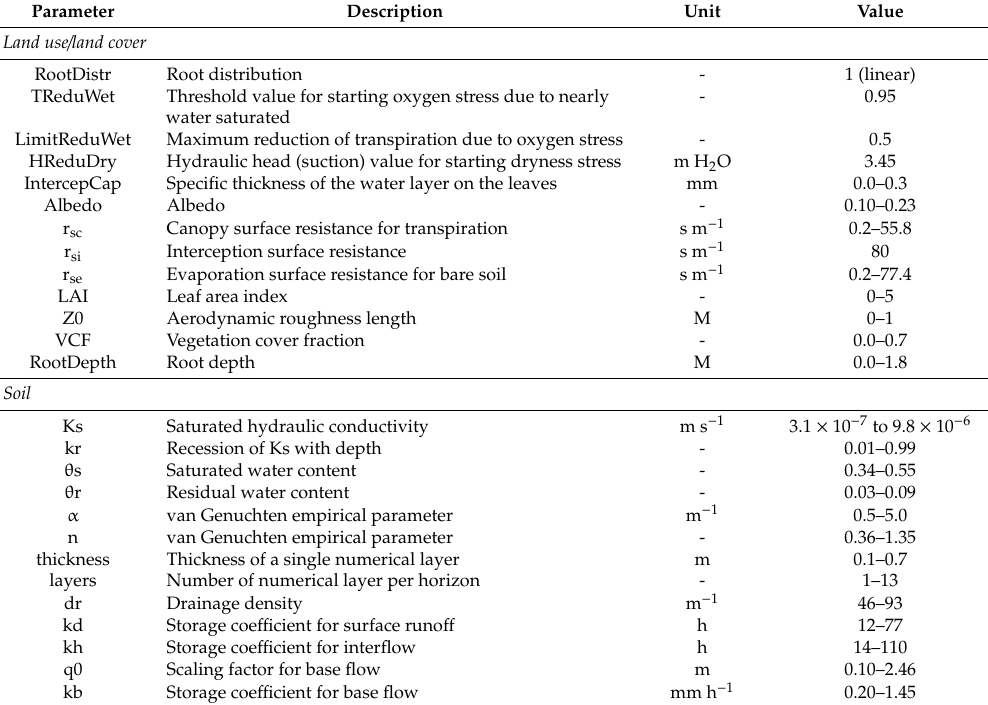
Table 8. Summary of the final WaSiM parameters for the Bankandi-Lo ffi ng